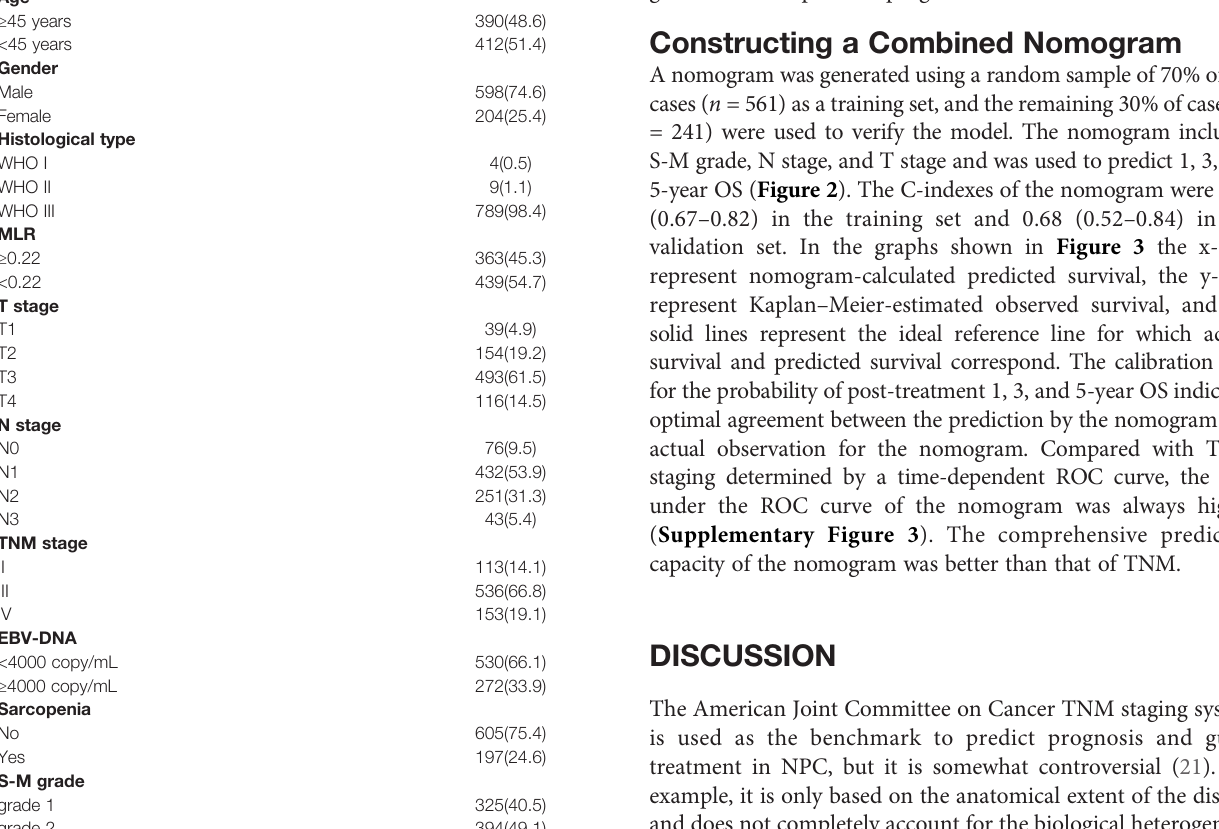
validation set. In the graphs shown in Figure 3 the x-axes represent nomogram-calculated predicted survival, the y-axes represent Kaplan – Meier-estimated observed survival, and the solid lines represent the ideal reference line for which actual survival and predicted survival correspond. The calibration plot for the probability of post-treatment 1, 3, and 5-year OS indicated optimal agreement between the prediction by the nomogram and actual observation for the nomogram. Compared with TNM staging determined by a time-dependent ROC curve, the area under the ROC curve of the nomogram was always higher ( Supplementary Figure 3 ). The comprehensive predictive capacity of the nomogram was better than that of TNM.